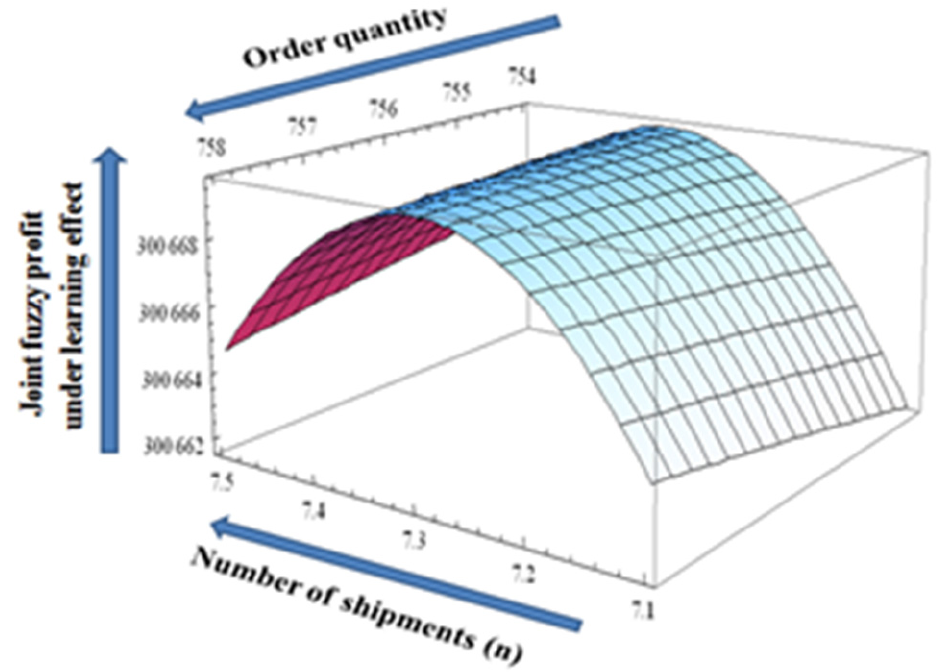
Figure 11. Concavity of the joint fuzzy profit with respect to the number of shipments and order quantity under learning in a fuzzy environment.